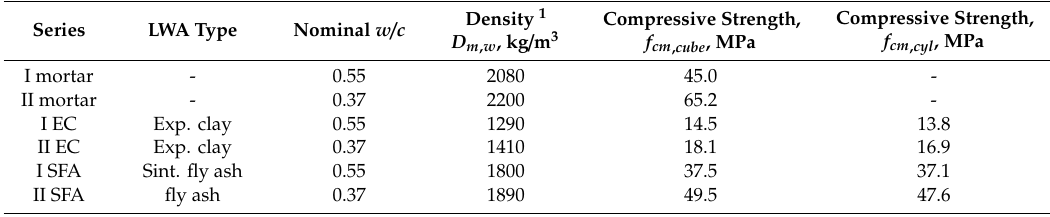
Table 4. Mean values of compressive strength and density determined on molded specimens.